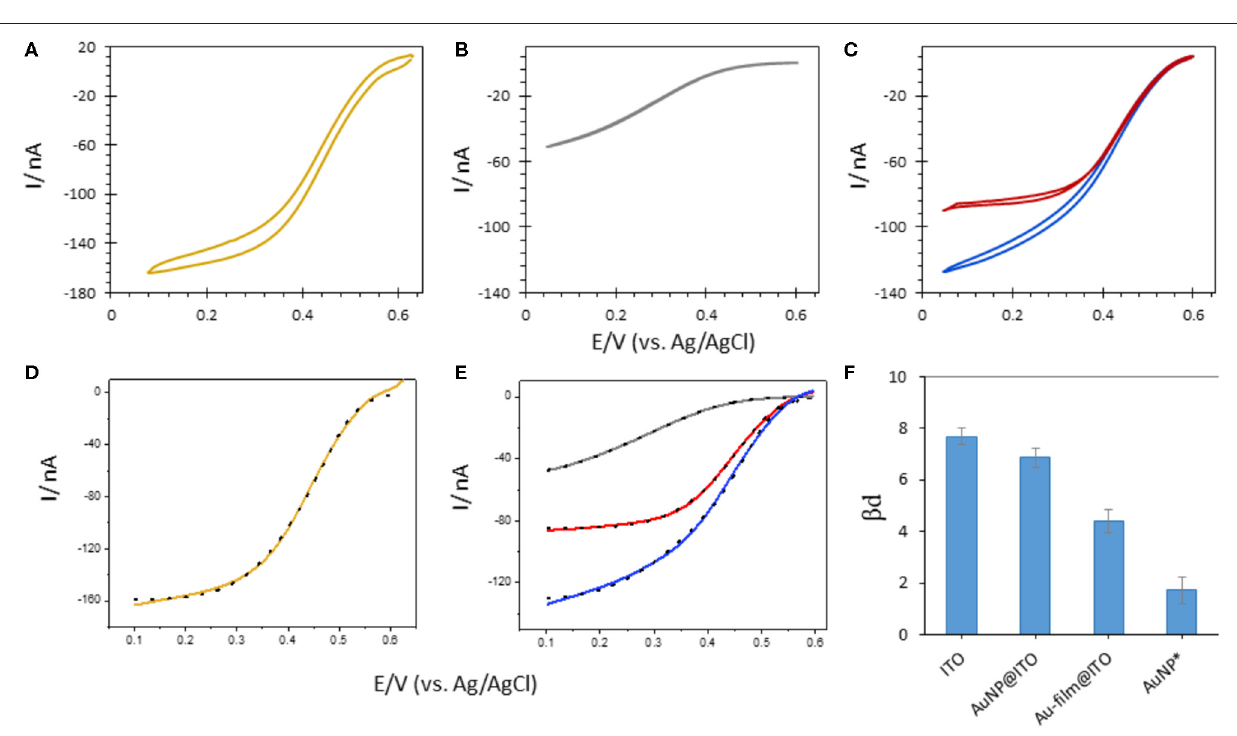
FIGURE 10 | CVs obtained after Mv BOD adsorption on 6-MHA functionalized (A) Au-film@ITO (B) bare ITO or (C) AuNP@ITO (blue curve) electrodes. In (C) the red curve is obtained after subtraction of 86% ITO CV signal from AuNP@ITO one. (D,E) Electrocatalytic modeling (black dotted line) of corresponding CVs (solid line). (F) Changes in β d upon Mv BOD adsorption as a function of different electrode surfaces. AuNPs* represents the values for average subtracted CV (CV AuNPs @ ITO – CV ITO86 % ). Scan rate 10 mV/s, 100mM phosphate buffer pH